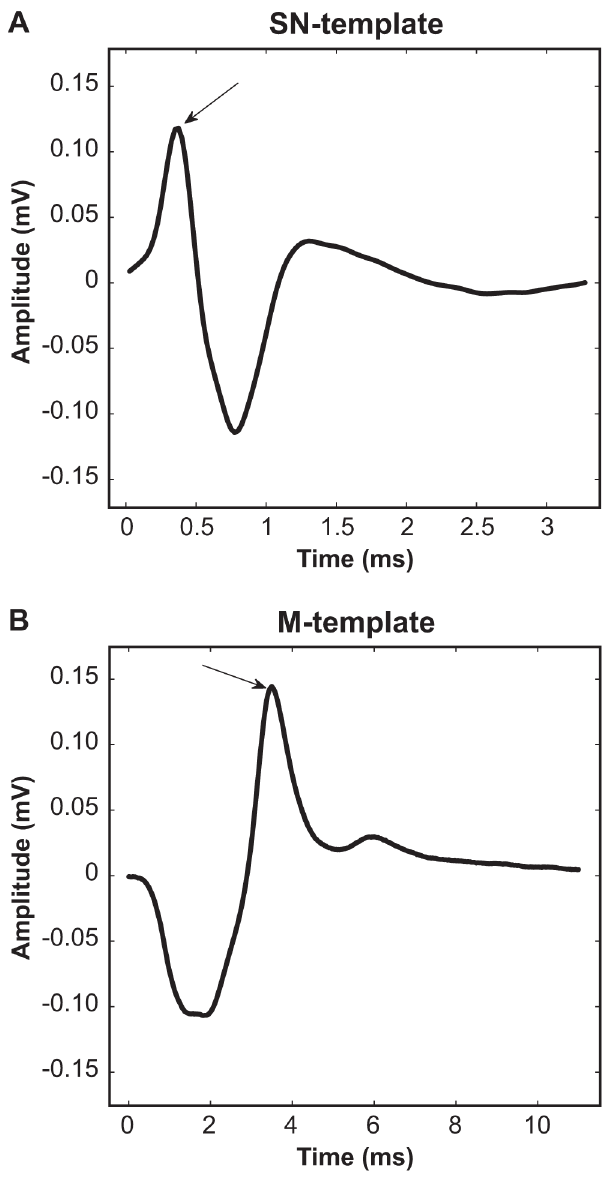
Fig 1. Generation of template signals used for waveform similarity analysis. Sural nerve (A) and tibial muscle EMG (B) template signals were generated from the intact side (left) of rats. The mean for each template was derived after individual responses were temporally aligned to the primary positive peak (arrows). See text for further